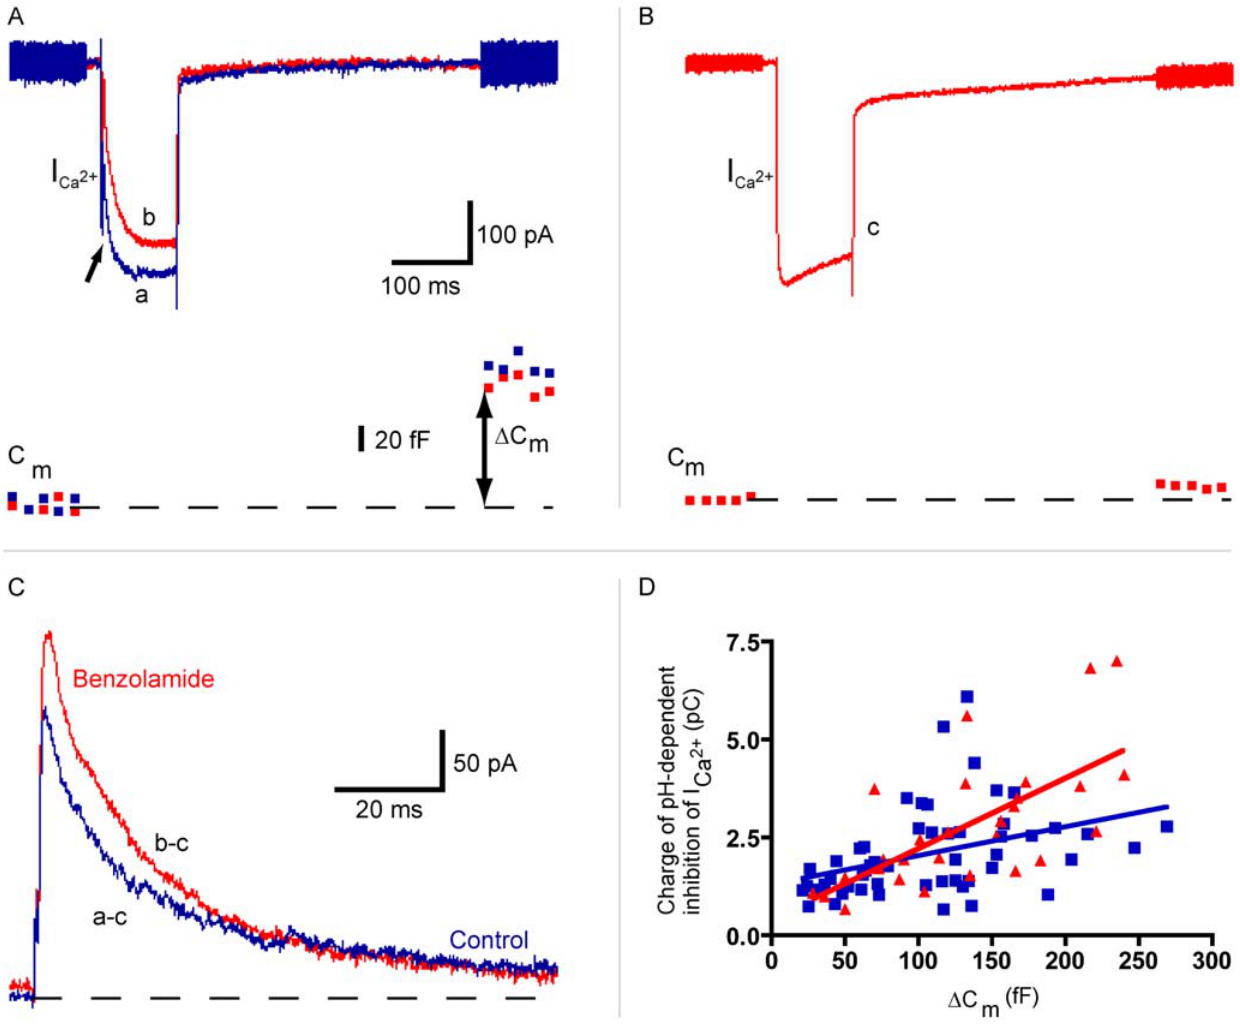
Figure 8. Benzolamide enhances pH-dependent inhibition of L-type Ca 2 + currents in isolated goldfish Mb bipolar cell terminals. A , Bath application of 100 m M benzolamide and 100 m M picrotoxin enhances the ‘‘pH-nose’’ inhibition of L-type Ca 2 + currents elicited by 100 ms steps from 2 60 mV to 2 10 mV. This inhibition is mediated by the exocytosis of protons co-packaged with glutamate. Upper traces: Individual voltage- clamp traces from two different isolated terminals in the same slice. In the continuous presence of picrotoxin (100 m M; a: blue trace), a 100 ms step to 2 10 mV produces an inward Ca 2 + current of nearly 400 pA that is inhibited by a rapidly decaying pH-nose (indicated by arrow) immediately following the onset of depolarization. Addition of benzolamide (100 m M; b: red trace) enhances the amplitude and area of the pH-nose. Voltage- clamp sine waves before and after the depolarizing step allow for the measurement of membrane capacitance change ( D C m ; exocytosis). Lower traces: Measurements of D C m corresponding to the traces shown above. The D C m in control is 158 fF (blue trace) and it is 132 fF (red trace) in the presence of 100 m M benzolamide. B , The pH-nose is absent from a pure Ca 2 + current, elicited by a 100 ms step to 2 10 mV following nearly complete run-down of exocytosis. Upper traces: Depolarization of an isolated terminal to 10 mV for 100 ms produces an inward Ca 2 + current of nearly 400 pA (c: red trace). Lower trace: The corresponding capacitance trace shows that exocytosis is almost completely absent. C , The exact charge transfer for each pH-dependent inhibition of I Ca2 + in ( A ) was calculated by scaling the original traces (traces a,b) to match the amplitude of the Ca 2 + current in ( B ), subtracting the pure Ca 2 + current trace (trace c) from the Ca 2 + current traces with pH noses (a,b), and integrating the area under the difference curve during the 100 ms depolarization to 2 10 mV. The pH-nose charge in the presence of 100 m M benzolamide (b–c) is 3.878 pC, and the pH-nose in control (a–c) is 2.854 pC. D , Bath application of 100 m M benzolamide (red triangles; n=29, 6 cells; control is blue squares; n=53, 8 cells) significantly increases the positive slope of the relationship between the size of the charge of pH-dependent inhibition of I Ca2 + and D C m . The slope of the linear regression for 100 m M benzolamide (red line; 0.018 + / 2 0.004) was significantly non-zero (p , 0.0001, r 2 =0.45) and significantly larger than the slope for control (p=0.017). The slope for control (blue line; 0.007 + / 2 0.002) was also significantly non-zero (p=0.004, r 2